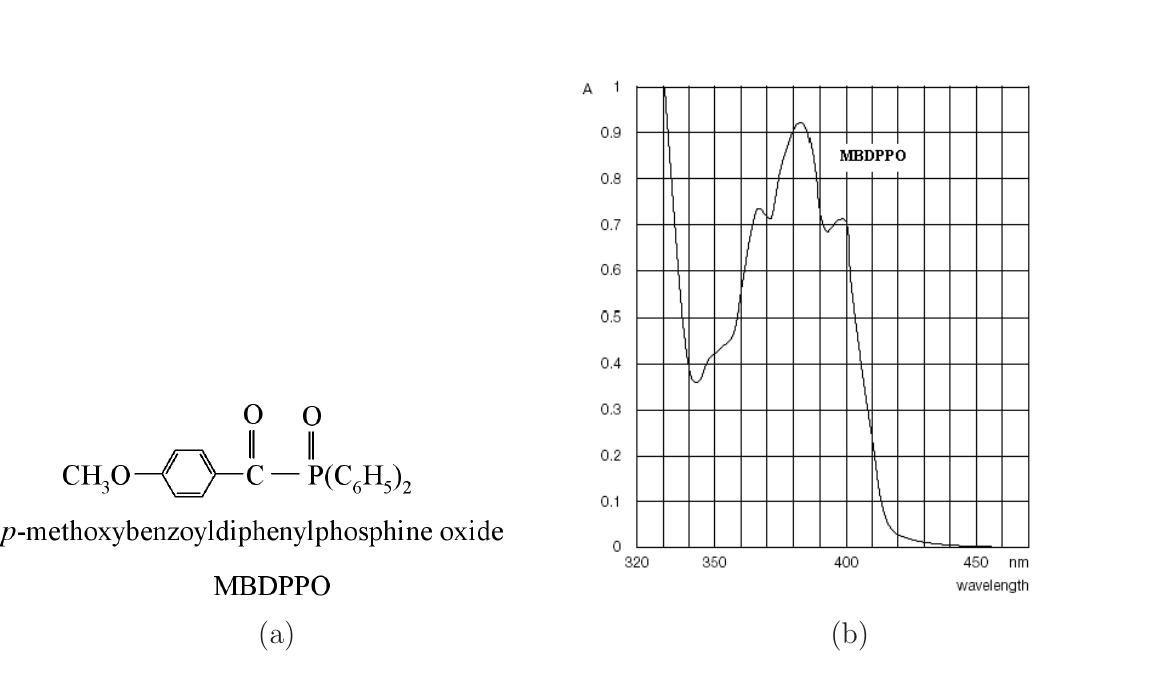
Fig. 1 Chemical formula of monomer.